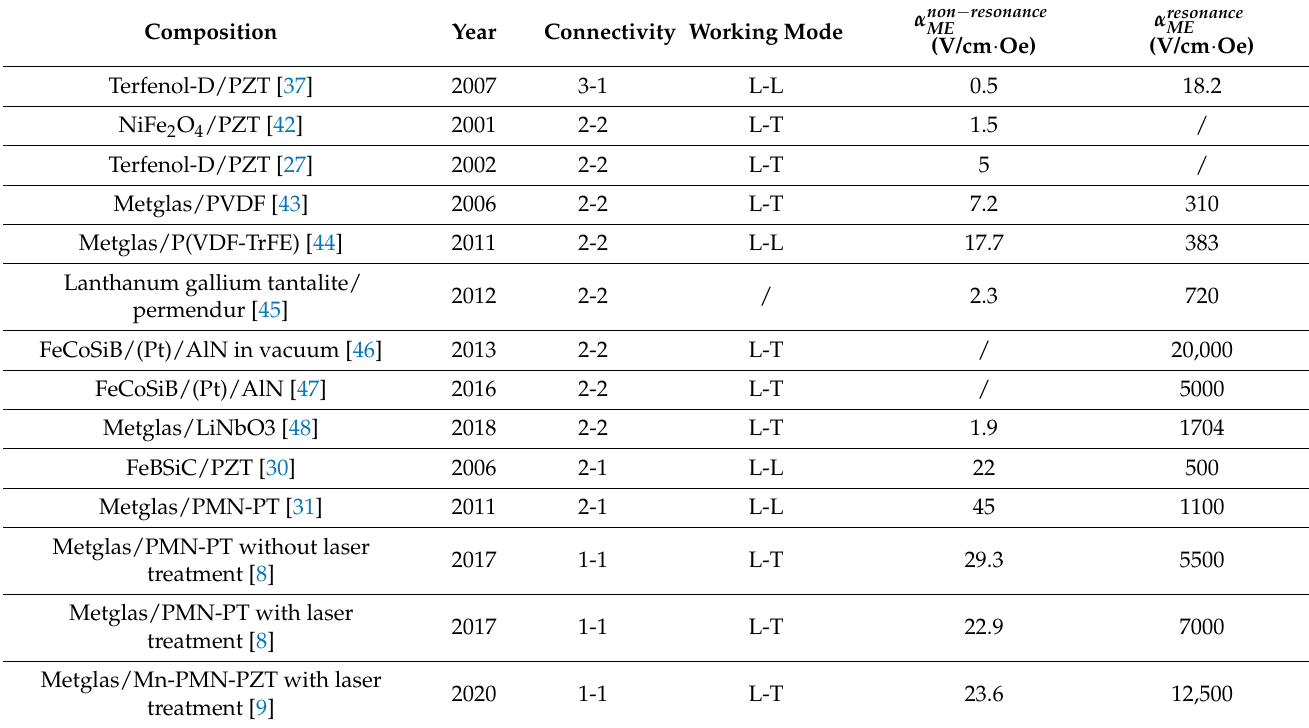
Table 1. Some ME laminates and their ME coupling